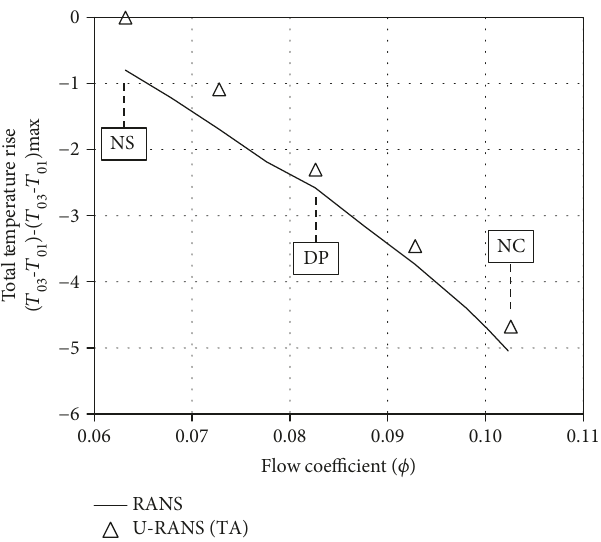
Figure 8: Static pressure recovery coe ffi cient of the vaned di ff user.